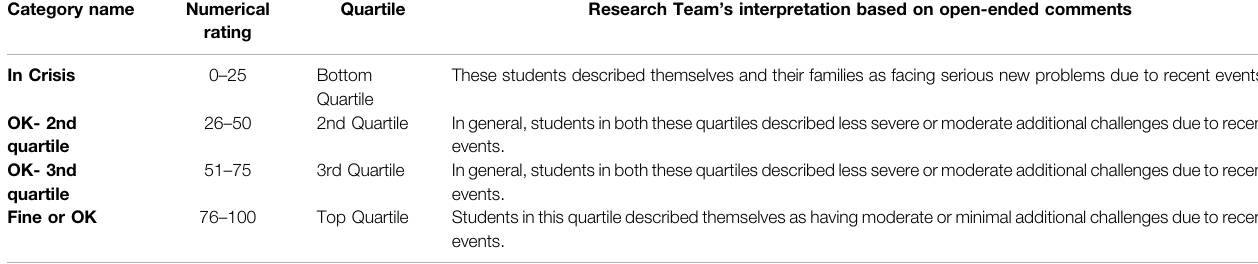
TABLE 2 | Overview of student